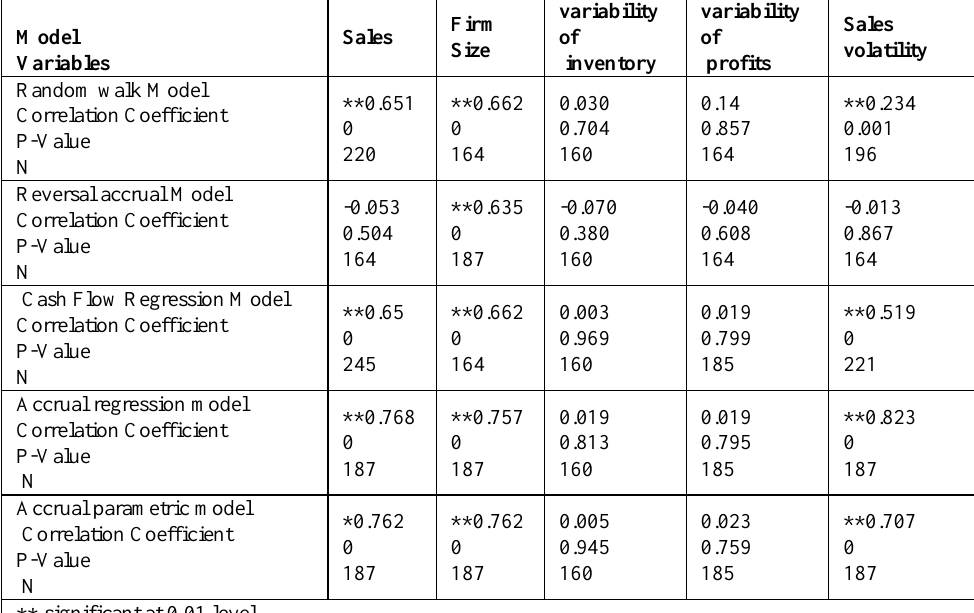
Table 12. Investigation of the Relationship between Cash Flow and Accrual Models in 2017 with the Companies